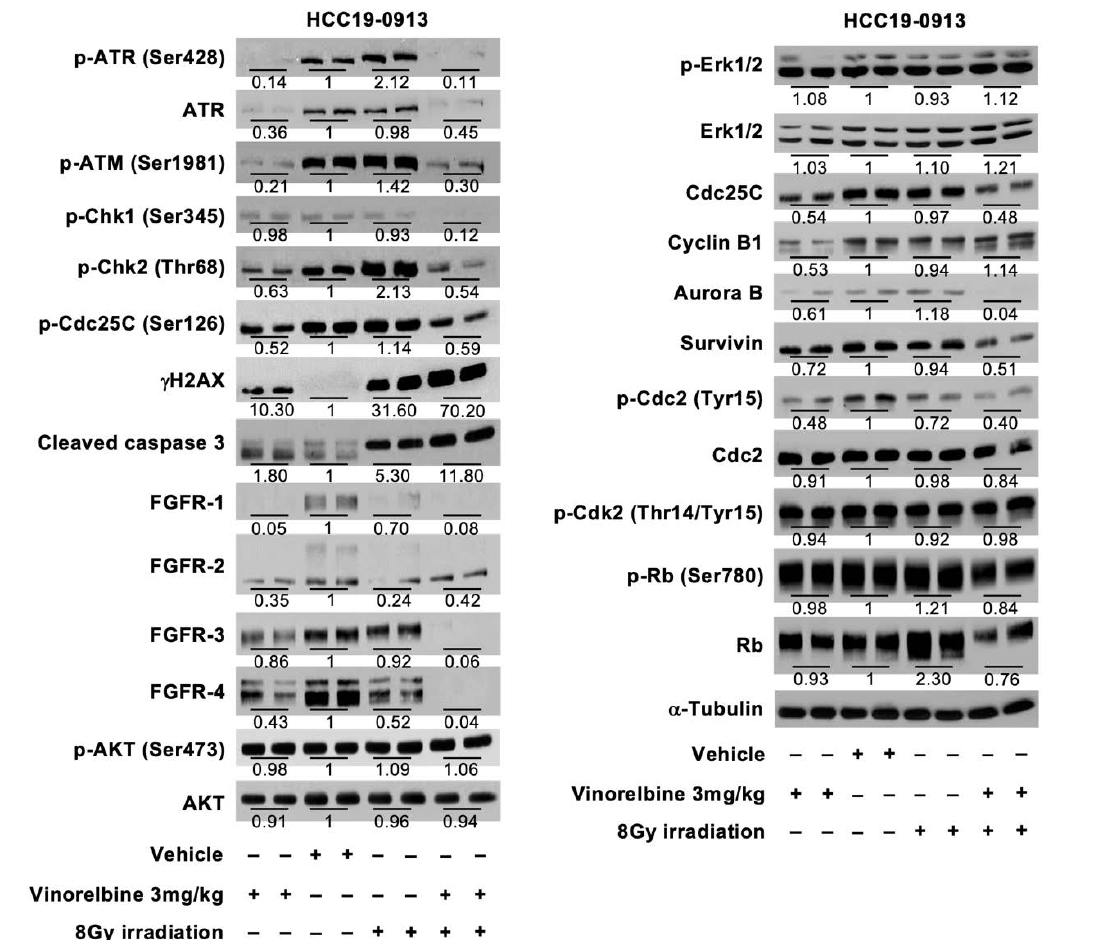
Figure 4. Effects of localized RT, Vinorelbine, and RT/Vinorelbine on the DNA repair pathway, receptor tyrosine kinases (RTKs), and its downstream targets in the HCC19-0913 model. Mice were subcutaneously implanted with HCC19-0913 tumors on both flanks and were irradiated with 8 Gy on the right flank, in the presence or absence of 3 mg/kg Vinorelbine. Tumor tissues were collected on day 2 post-RT, and lysates were subjected to Western blot and quantification analyses, as described in Appendix A. The intensity ratio of each band is expressed as the fold change relative to control. Representative blots are shown.